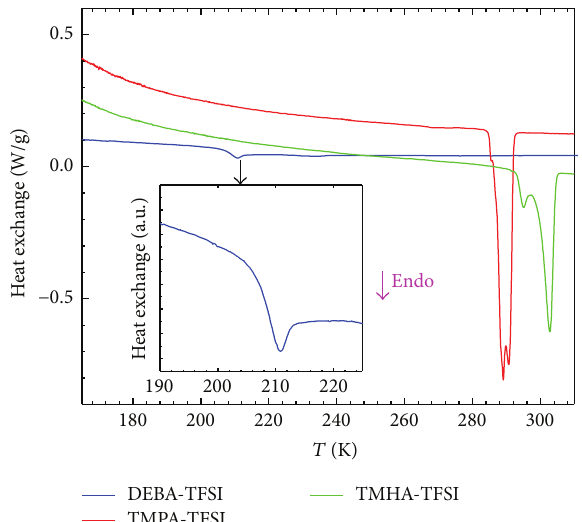
Figure 1: DSC curves of DEBA-TFSI measured at 5 K/min on heating. For comparison the curves of TMPA-TFSI and TMHA-TFSI measured in the same conditions are